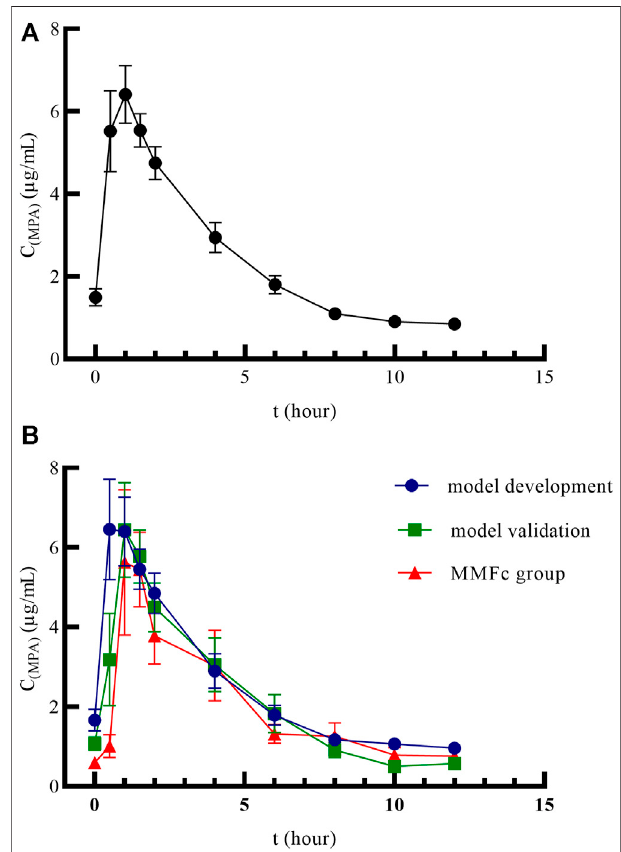
FIGURE1 | Mean plasma concentration – time curves of MMFdt in all patients (A) , model building group, model validation group and MMFc group (B) in heart transplant recipients. MMFdt, mycophenolic mofetil dispersible tablets; MMFc, mycophenolate mofetil capsule; MPA, mycophenolic acid; C (MPA) , concentration of MPA; t, time.